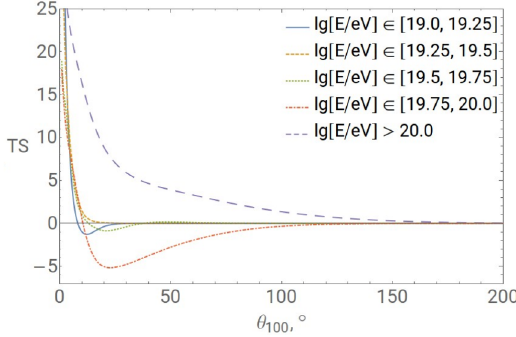
Figure 2. The test statistics TS ( θ 100 ) calculated the data in five energy bins as indicated on the plot.